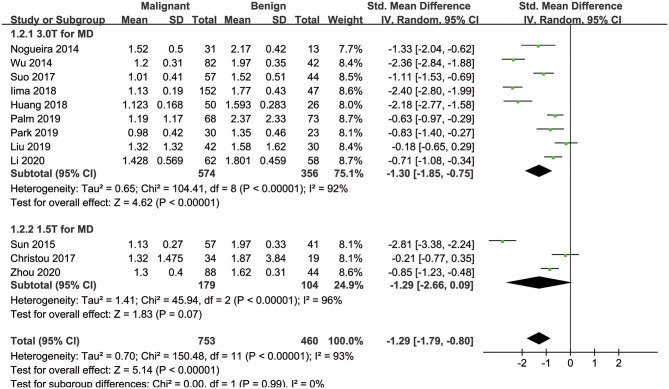
Forest plot of the mean value of the mean diffusivity (MD) between malignant and benign breast lesions. The standardized mean differences indicated that breast cancers had a significantly lower MD than benign lesions.